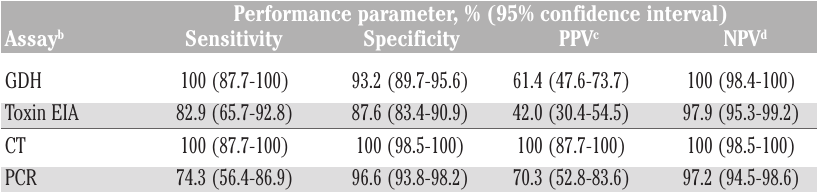
Table 2. Performance characteristics of different C. difficile testing modalities compared to a combined standard.